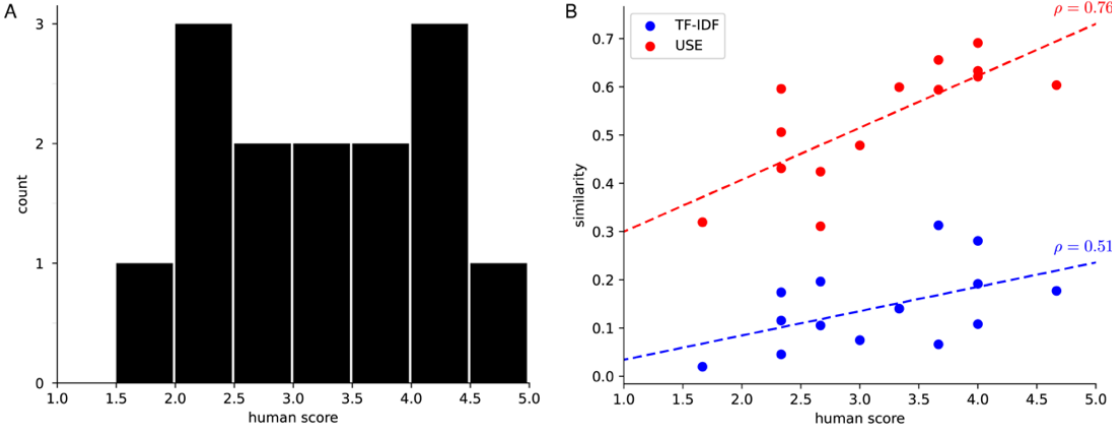
Figure 4. Histogram of similarity scores calculated by the human evaluators ( A ) and their compar- ison to NLP-based similarity measures ( B ).